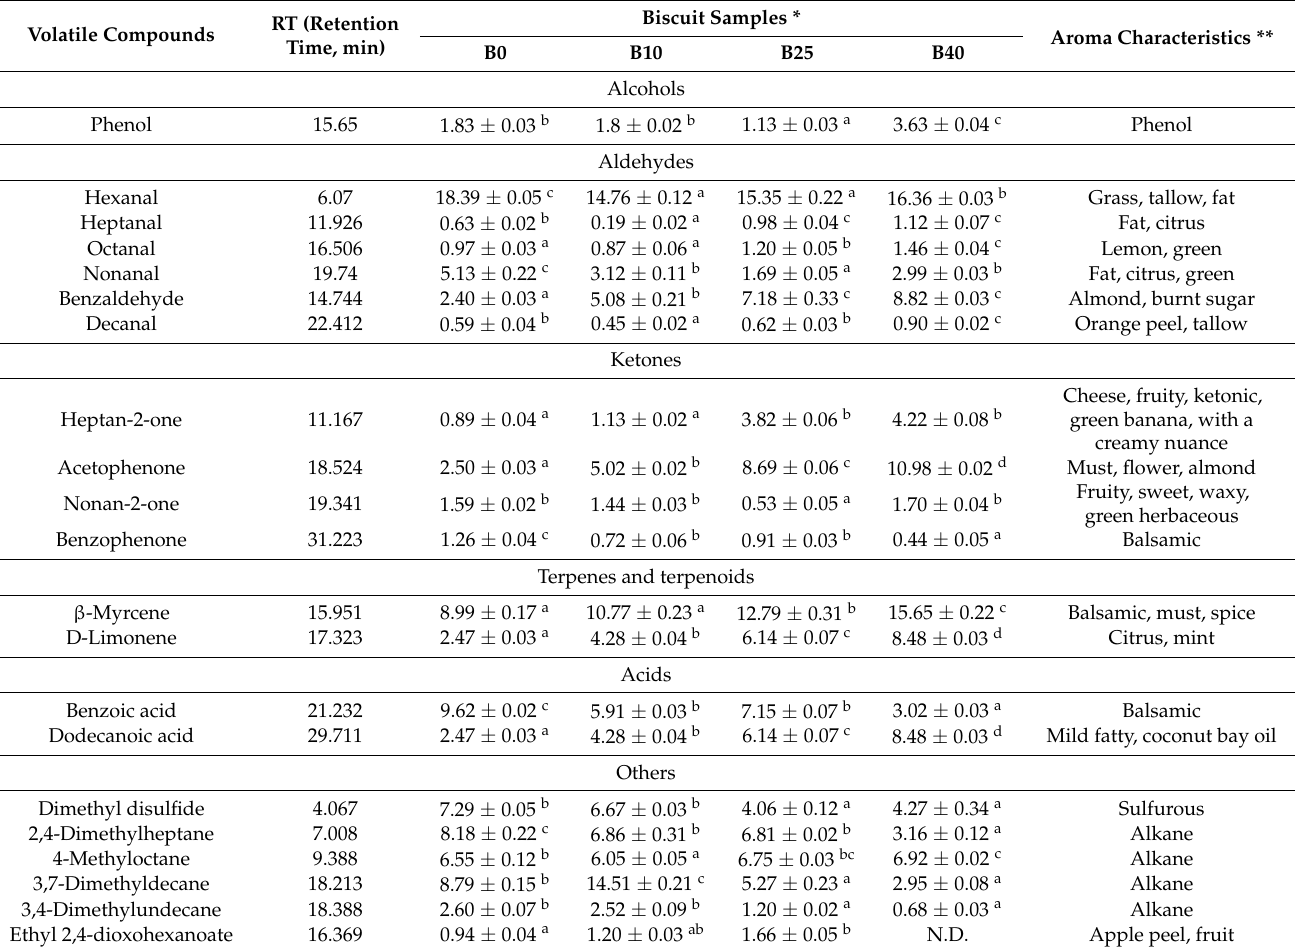
Table 6. Volatile compounds content of the biscuits with roasted flaxseed